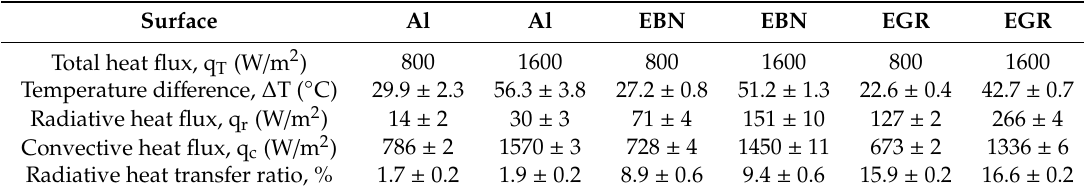
Table 7. The heat transfer rates by convection and radiation under forced convection *. Surface